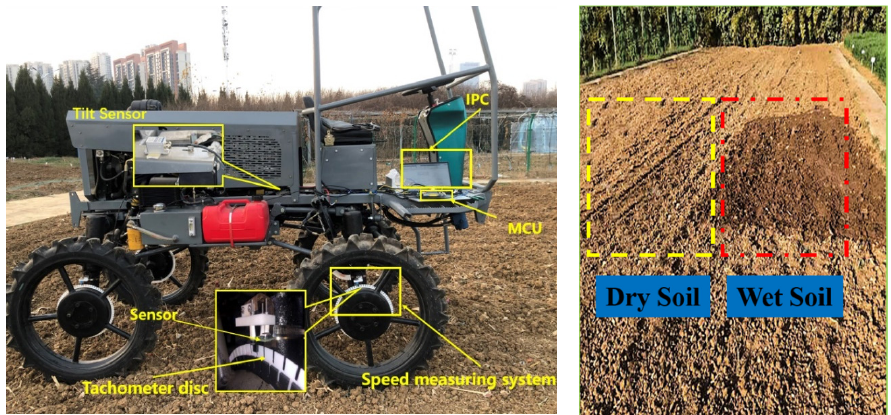
Figure 16. Opposite pavement experiment.